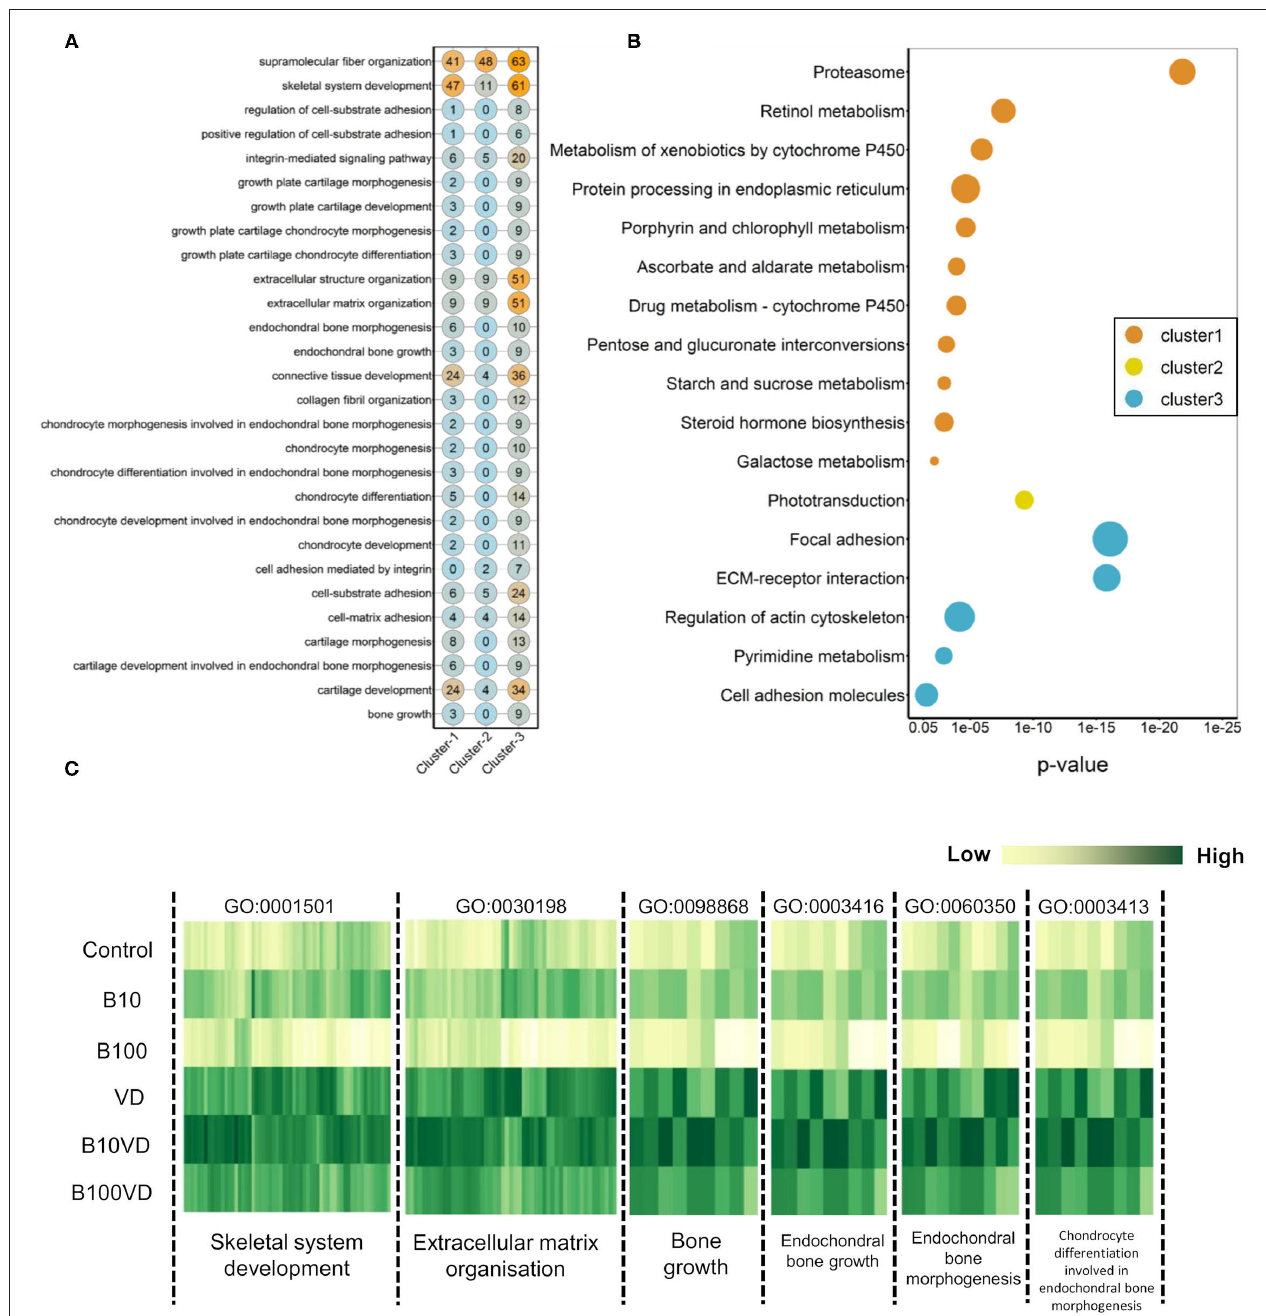
FIGURE 5 | (A) Matrix visualizing the number of DEGs falling under enriched GO terms involved in skeletal system development. Y-axis highlights the key enriched GO terms, and X-axis describes the cluster number. The numbers within each circle indicate the total genes falling within that GO term in each cluster. (B) Bubble plot visualizing KEGG pathways significantly enriched ( p < 0.05) across the three different clusters. Color of the bubbles indicates the cluster they fall into, and size of the bubble indicates the number of genes. (C) Heatmap visualizing normalized expression values of genes contributing to enriched skeletal GO terms in the cluster 3. Y-axis highlights the different treatment groups, and X-axis describes the enriched GO